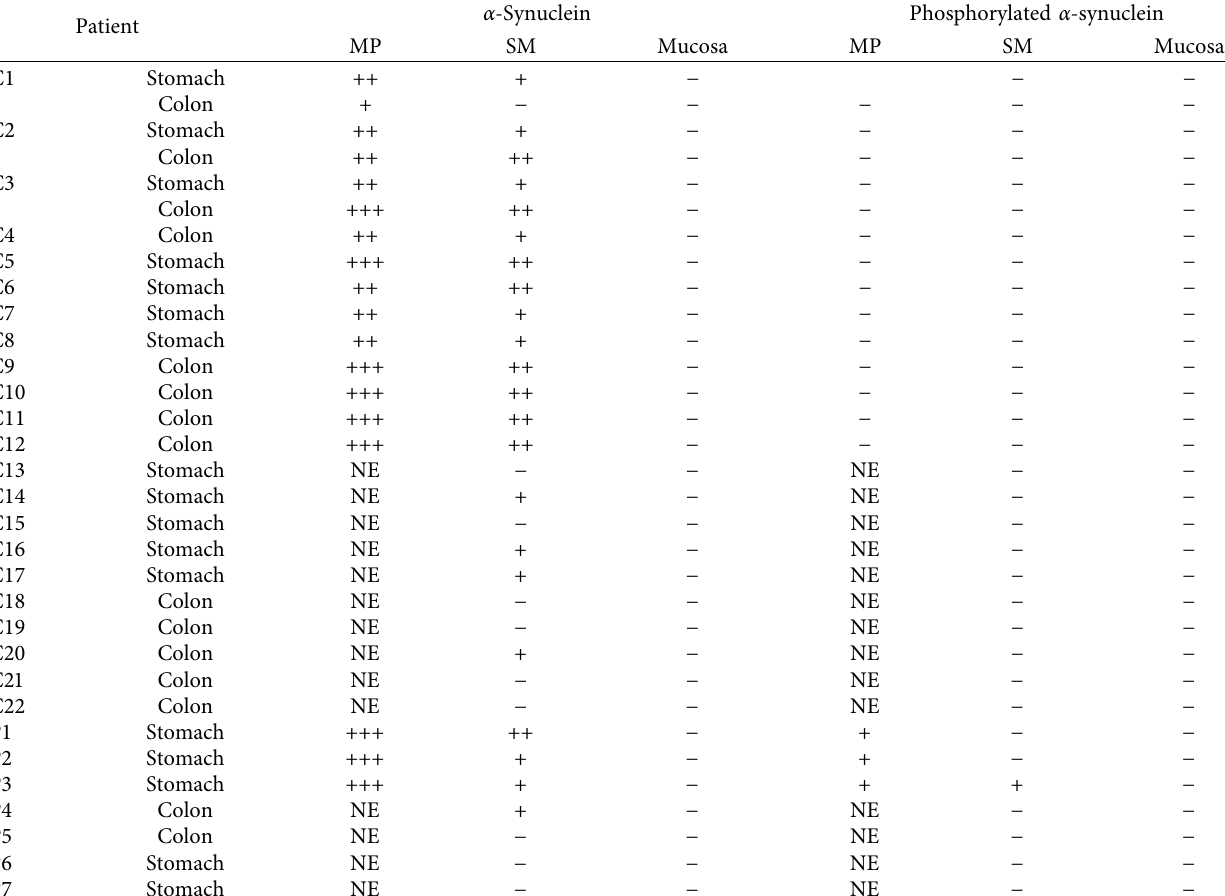
Table 3: Immunohistochemical findings in